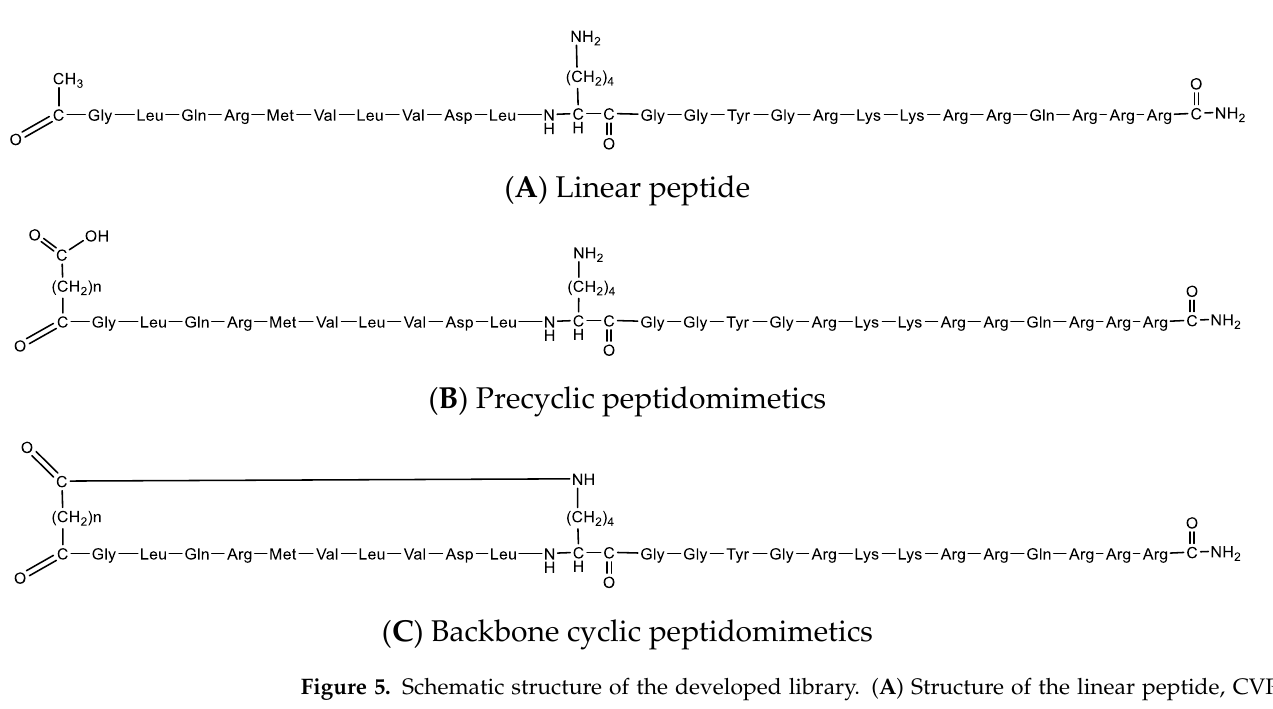
Figure 5. Schematic structure of the developed library. ( A ) Structure of the linear peptide, CVP-198; ( B ) structure of the precyclic peptidomimetics, CVP-201 and CVP-202; and ( C ) structure of the backbone cyclic peptidomimetics, CVP-199 and CVP-200.